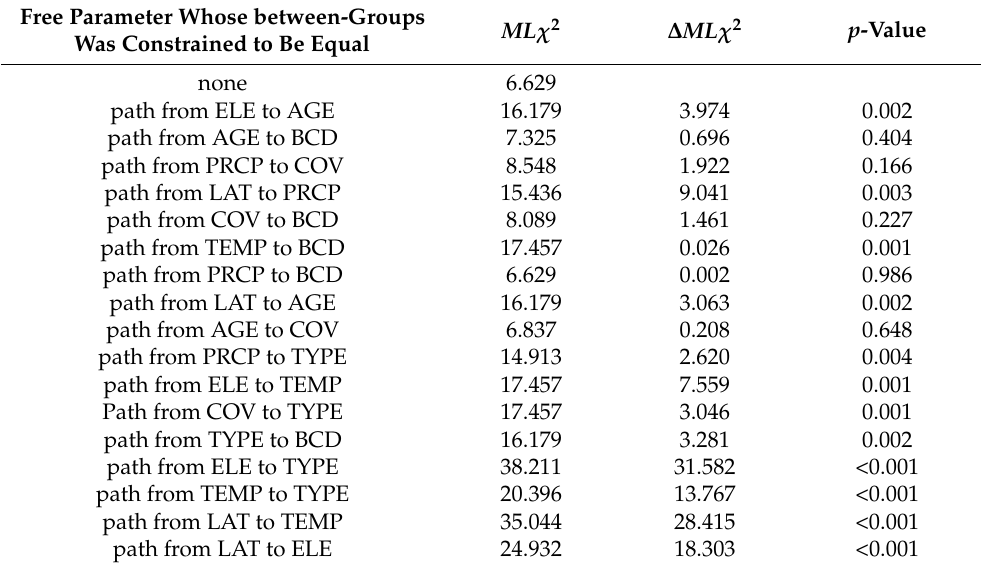
Table 3. The results of comparisons of a series of nested models based on a multigroup structural equation model of the natural coniferous forests and broad-leaved forests. A non-significant value, highlighted in bold, indicates that the path contribution to the model is equal between forest types. The first row shows the maximum likelihood χ 2 estimates ( ML χ 2 ) when all parameters are free. The remaining rows show the result by constraining one parameter at a time. The difference between the fully free model and the rest is given as ∆ ML χ 2 , and the p -value indicates the probability that the con- straint of that parameter changes the model. Bonferroni-corrected p -value threshold, 0.05/15 = 0.003. BCD, biomass carbon density; AGE, stand age; COV, stand coverage; TYPE, forest type; LAT,